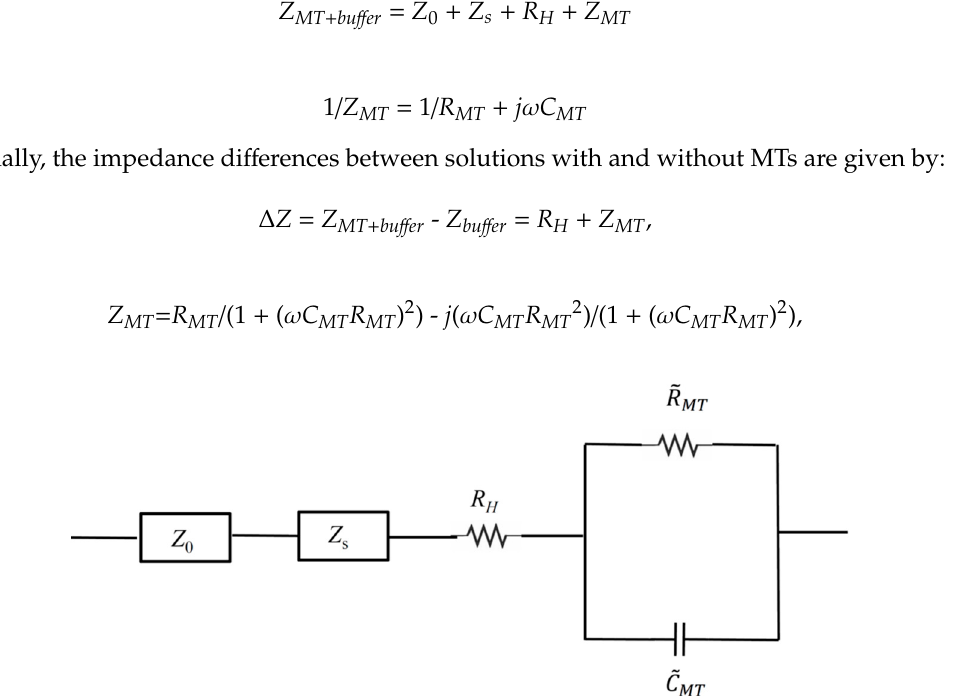
Figure 7. The equivalent electrical circuit model representing the microtubule network as a parallel RC circuit, with network resistance R MT and capacitance C MT . The external element has impedance Z 0 , while solution has impedance Z s . R H is the small constant resistance that is ascribed to small fraction of unpolymerised tubulin that is present in MT containing solutions.